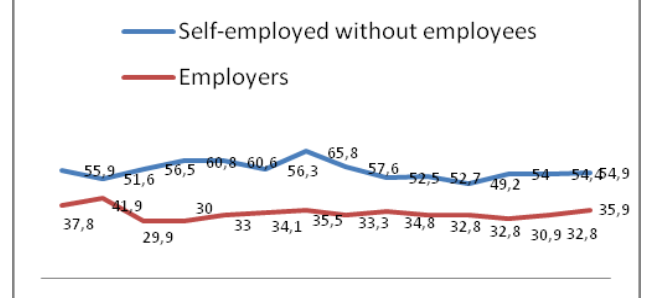
Fig. 4. The dynamics of the number of the employers (thousand people) and self-employed without employees (thousand people) during 2000-2013 (compiled by the author with reference to Eurostat